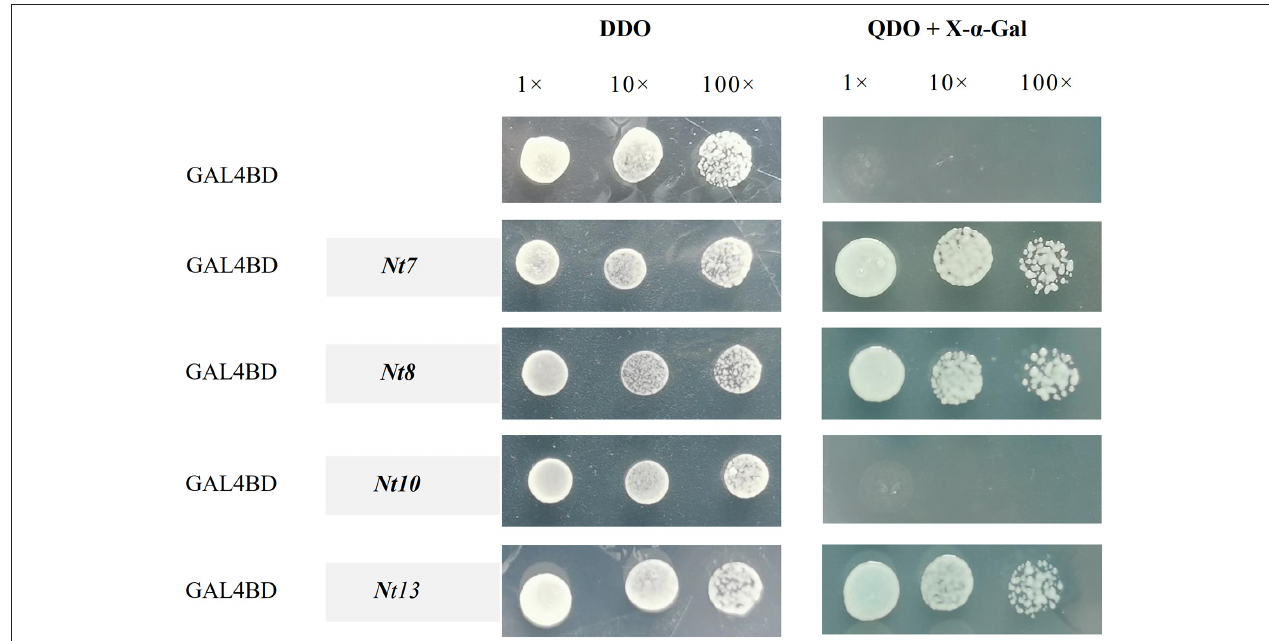
FIGURE 7 | Transactivation analysis of Nt7 , Nt8 , Nt10 , and Nt13 . Genes were combined into the GAL4 (BD) DNA binding domain in pBD-GAL4, with the empty pBD-GAL4 vector as the negative control. The transformed yeast cells were incubated on DDO (SD/-Leu-Trp) and QDO (SD/-Leu-Trp-His-Ade) with X- α -Gal. The yeast was diluted 10 and 100